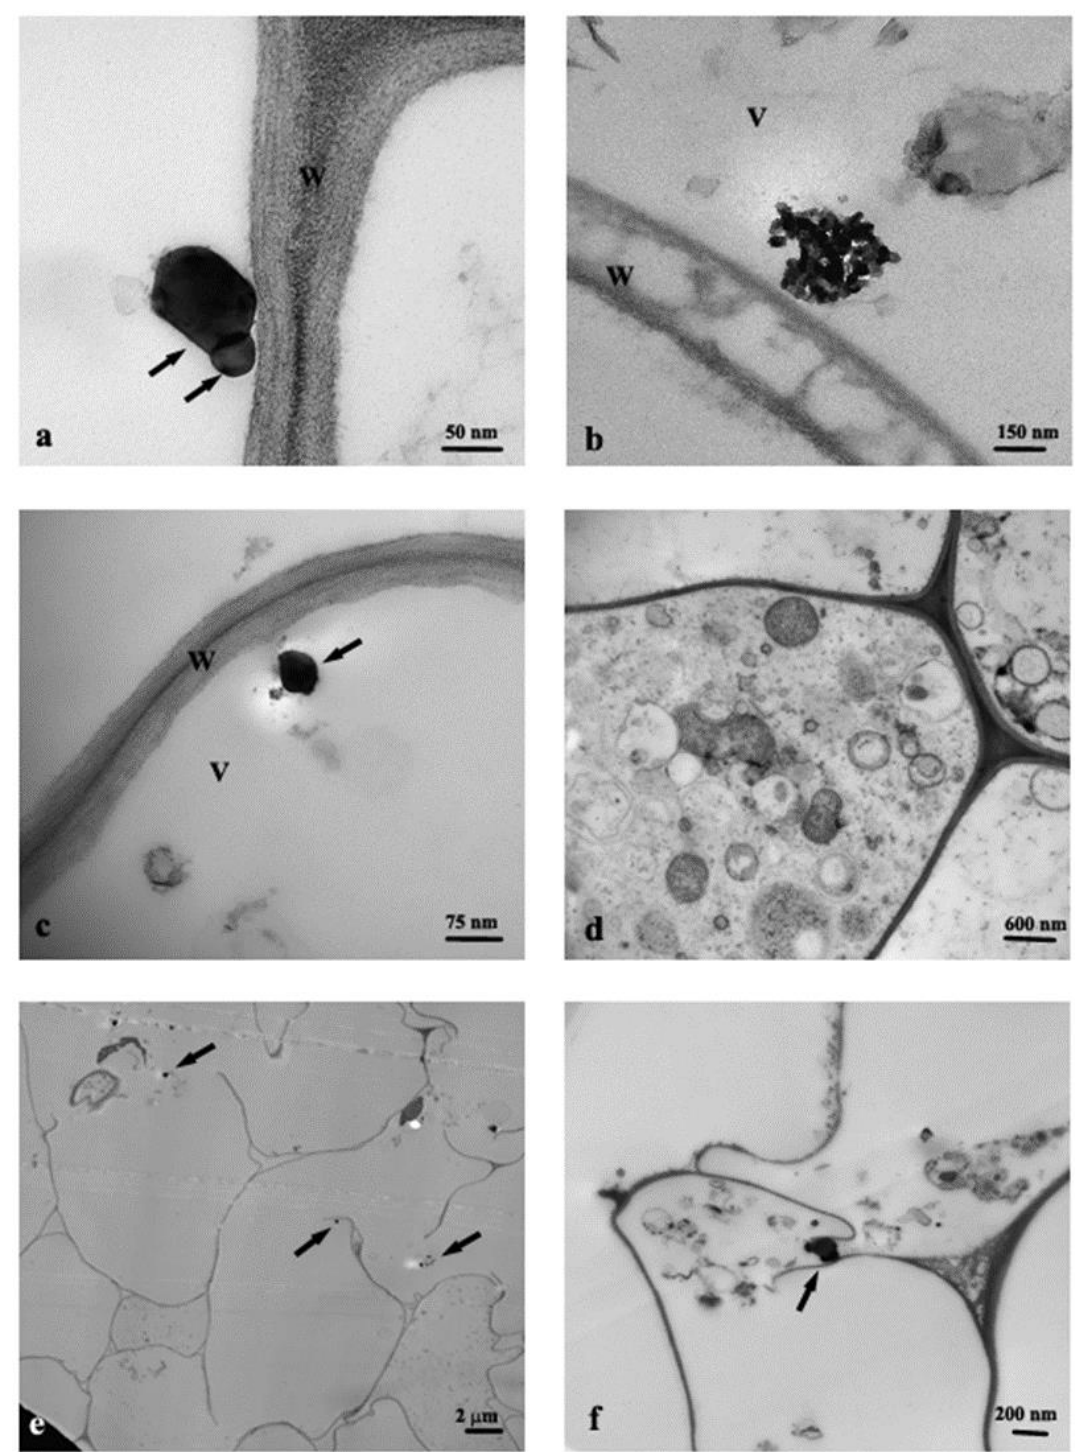
Figure 2. TEM images of roots cross-section: ( a ) C, control, NPs (arrows); ( b ) C, control, plasma- lemma-wall detachment (asterisk); ( c – f ) Ana800 treatment, NPs (arrows), a crystal in a mitochon- drion (double arrow). c, chromatin; IC, intercellular space; M, mitochondrion; W, cell wall.